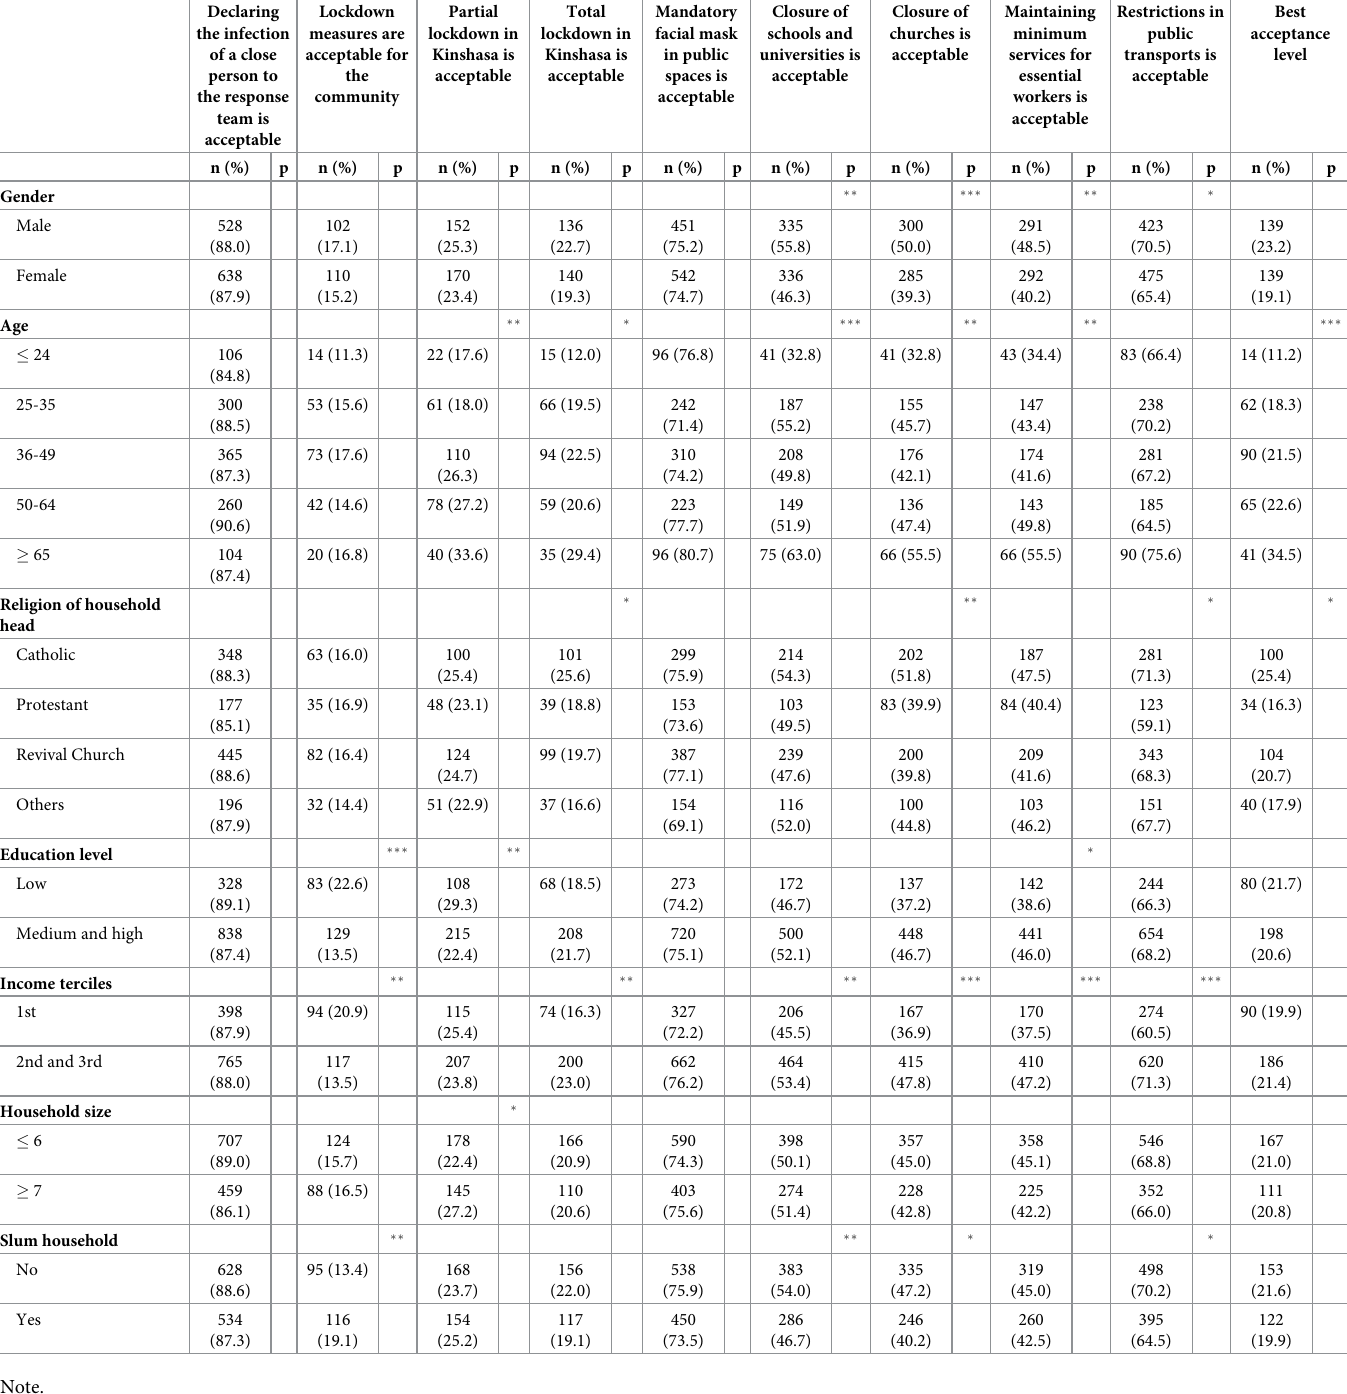
Table 5. Acceptability of COVID-19 measures according to baseline